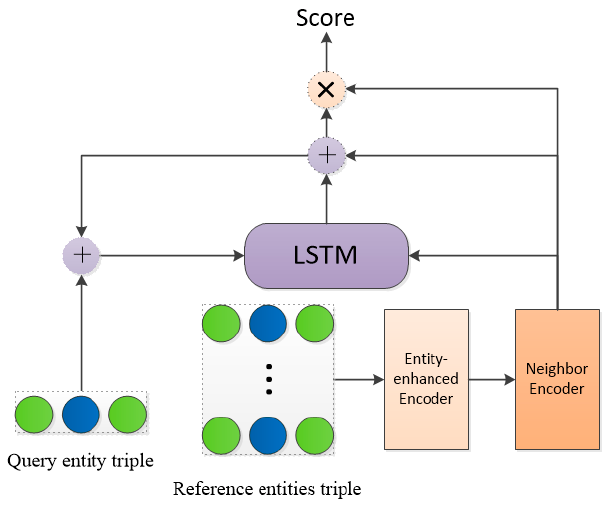
Figure 6. The schematic diagram of the matching processor process.